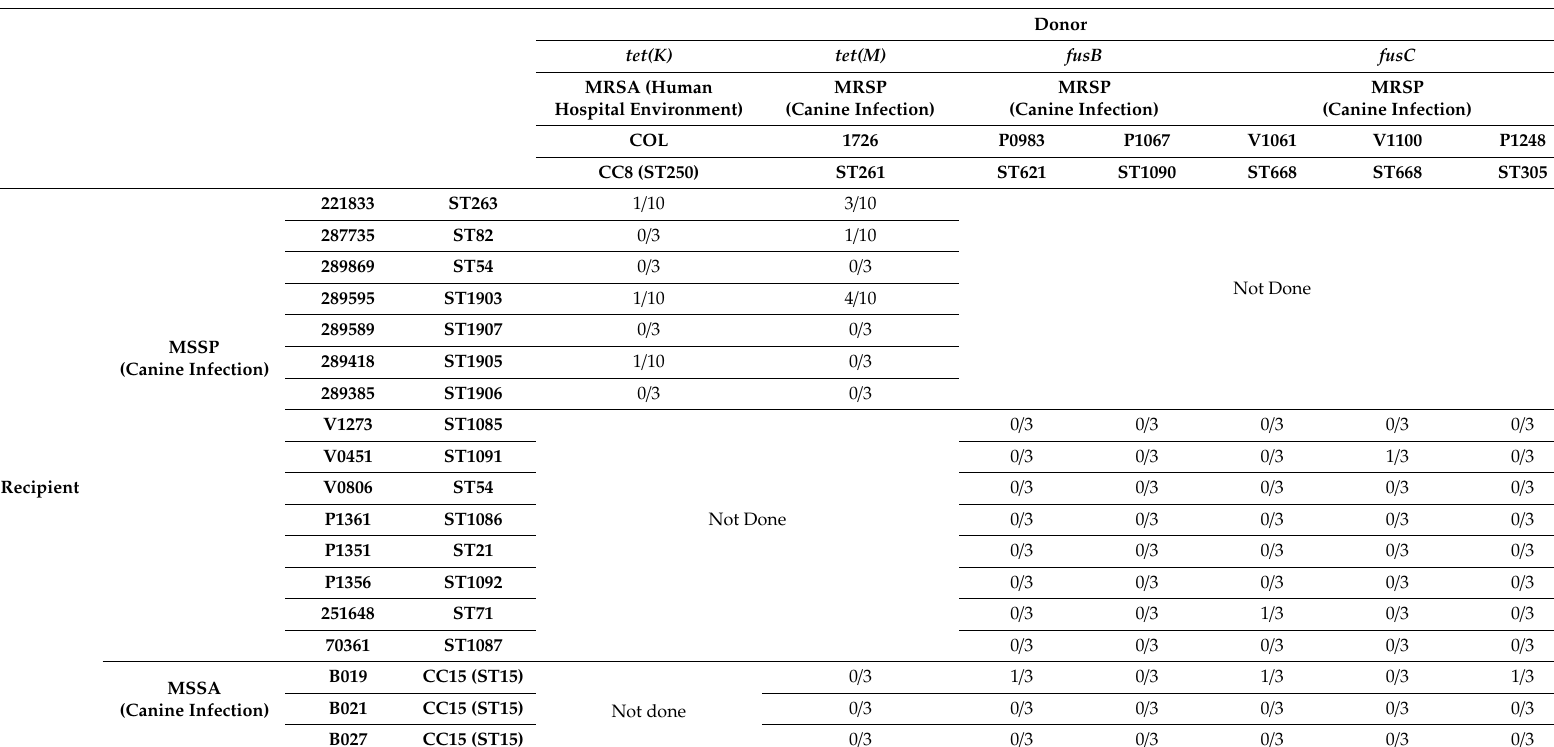
Table 1. Results from transduction assays using two tetracycline- and five fusidic acid-resistant bacterial donors (MRSA and MRSP), and 27 MR- and MS- S. aureus and S. pseudintermedius recipients. Numbers represent transduction assays with the growth of more than two-fold higher bacterial colonies than negative control plates, compared to the number of replicate attempts. For tetracycline resistance, confirmation of successful transduction was made by PCR. For fusidic acid assays, all putative transductant colonies were subsequently shown not to carry fusB or fusC ; mutations in fusA were identified by